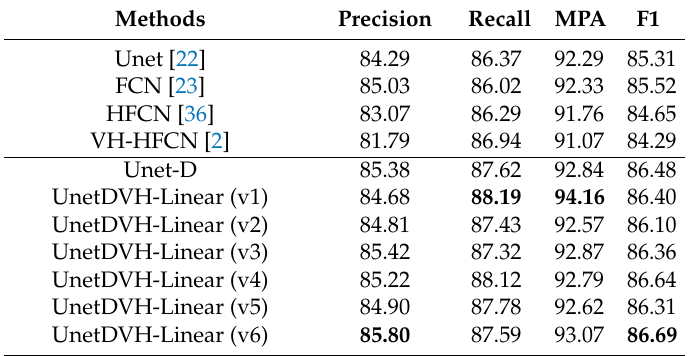
Table 5. Compared with different position of VH-stage for DVH block and v9h9 block on SS dataset